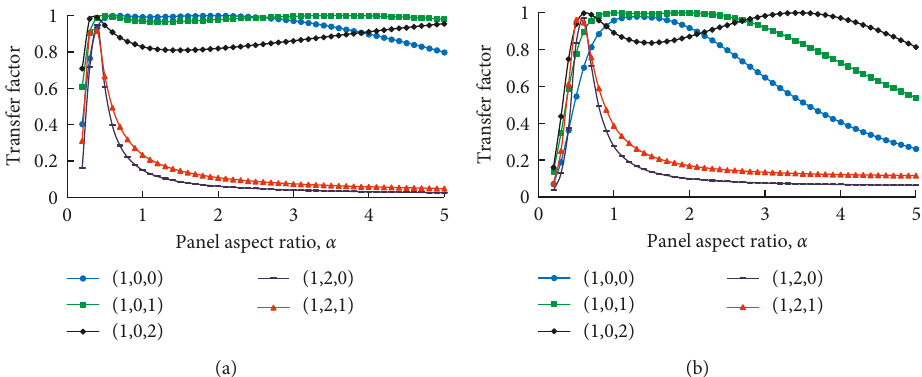
Figure 8: Effect of panel aspect ratio on the coupling property of the panel-enclosure coupled system with different panel boundary conditions: panel mode (2,1). (a) Simply supported panel mode (2,1). (b) Clamped panel mode (2,1).